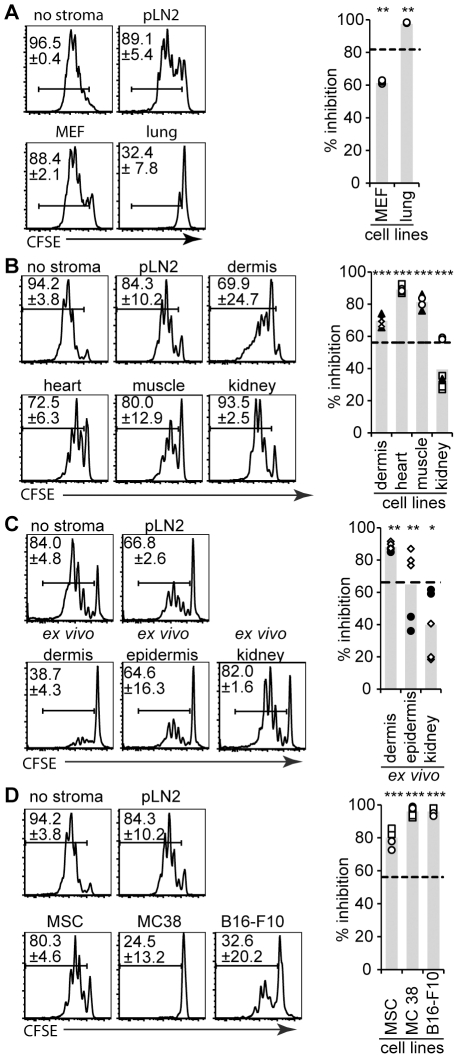
Stromal cells from various non-lymphoid organs decrease antigen-specific T cell proliferation.The T cell activation assay (see legend of Fig. 1) was performed in presence of either stromal cell lines (A,B,D) or ex vivo isolated stromal cells (C). OT-I T cells co-cultured for 3 days were analyzed for CFSE dilution using flow cytometry. Representative histograms of CFSE dilution (left panel) and the number of proliferating OT-I cells as percentage inhibition are presented (right panel, as in Fig. 1). Shown are assays with a (A) mouse embryonic fibroblast line (MEF) and lung fibroblast line, (B) lines derived from different non-lymphoid organs (dermis, heart, femoral muscle, kidney), (C) ex vivo isolated adherent cells from the dermis, epidermis or kidney, (D) Mesenchymal stem/stromal cell (MSC) line and the tumor cell lines B16-F10 (melanoma) and MC-38 (colon carcinoma). (A–D) n≥3, representative for ≥2 experiments. Different symbols indicate different experiments. * P<0.05, ** P<0.01, *** P<0.001, if not indicated otherwise p-values are relative to ‘no stroma’. The dotted line indicates the inhibition observed by pLN2 cells within the same experiment.